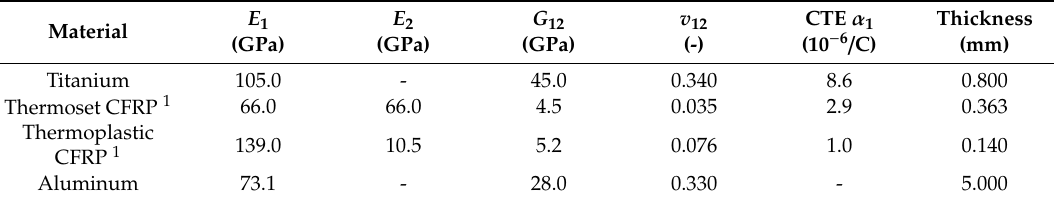
Table 1. Engineering constants, coe ffi cients of thermal expansion (CTEs), and thicknesses of the materials constituting the titanium–CFRP adhesive